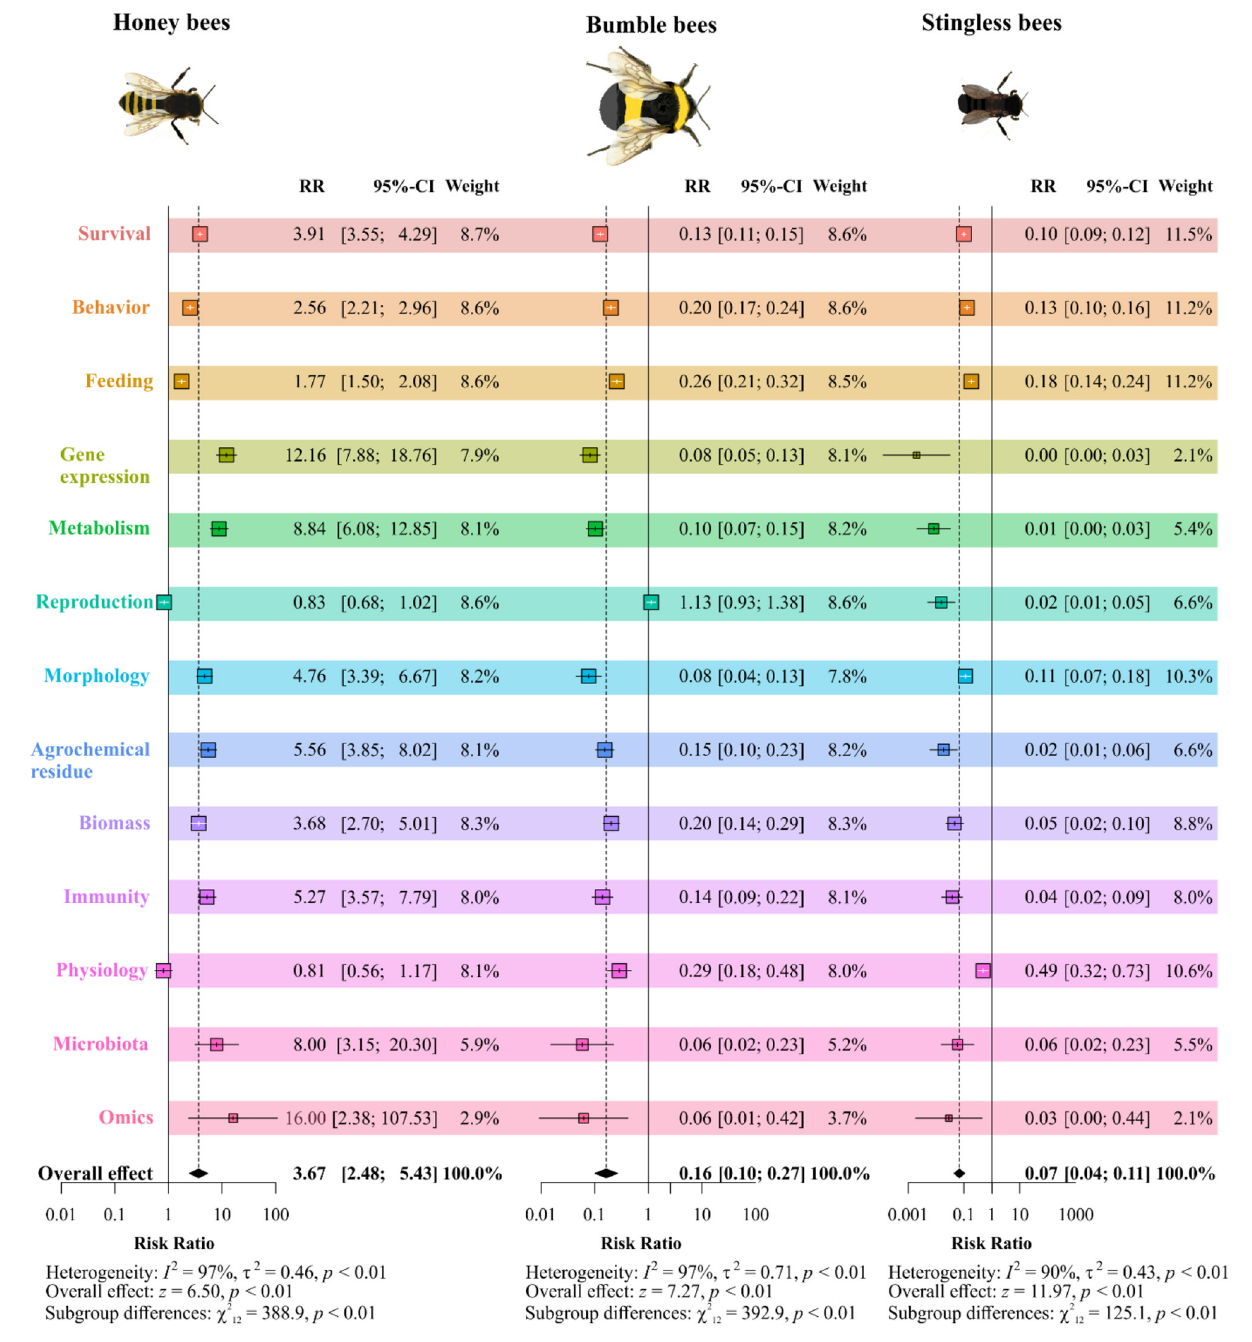
species). In countries such as Brazil, Colombia, Mexico, and Costa Rica, stingless bees represent ∼ 50–70% of all flower visitations by bees (Grüter, 2020). Despite this, toxicological